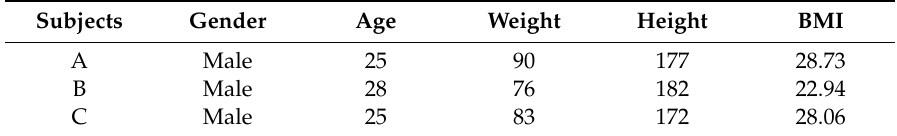
Figure 9. Raw and filtered waveforms measured at a distance of 1 m using the proposed radar.